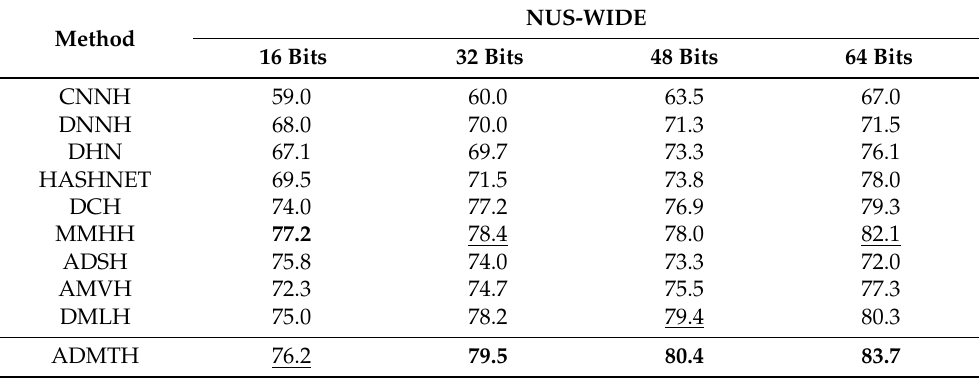
Table 4. Retrieval precision compared with baselines presented in MAP on